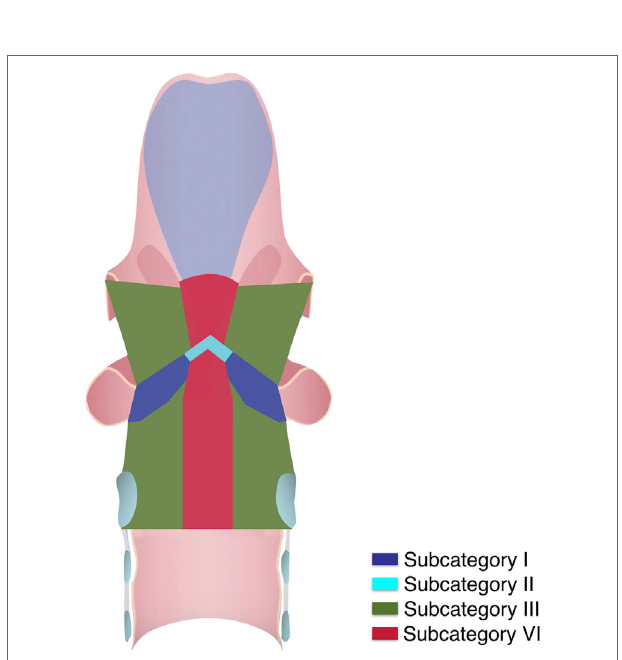
FigUre 5 | Three-dimensional map of the isoprognostic zones I, II, III, and VI, view from inside.